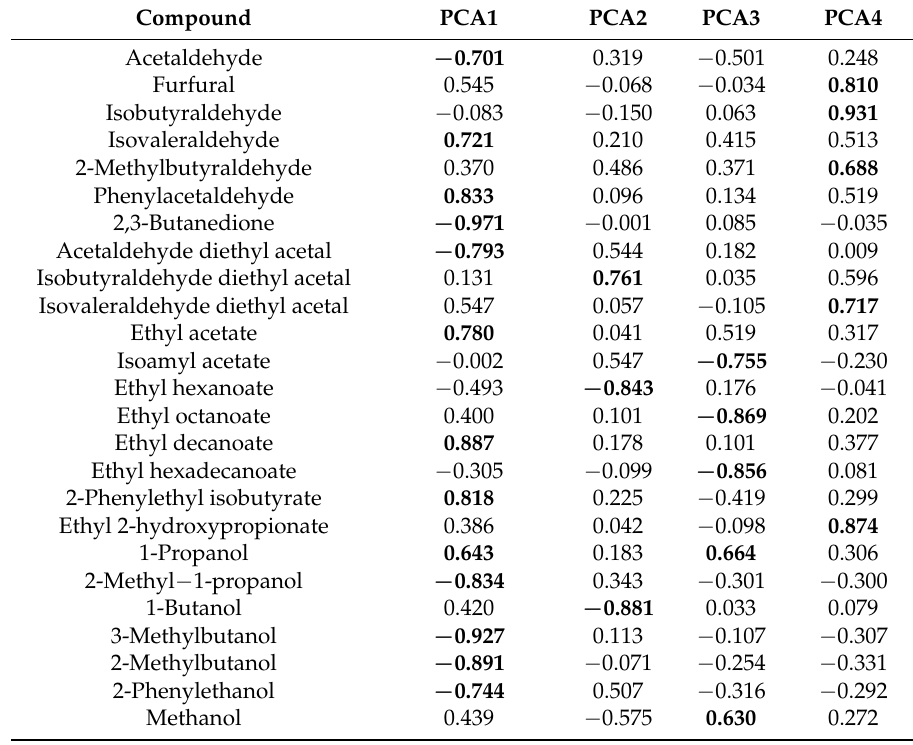
Table 9. Values of the charge factors